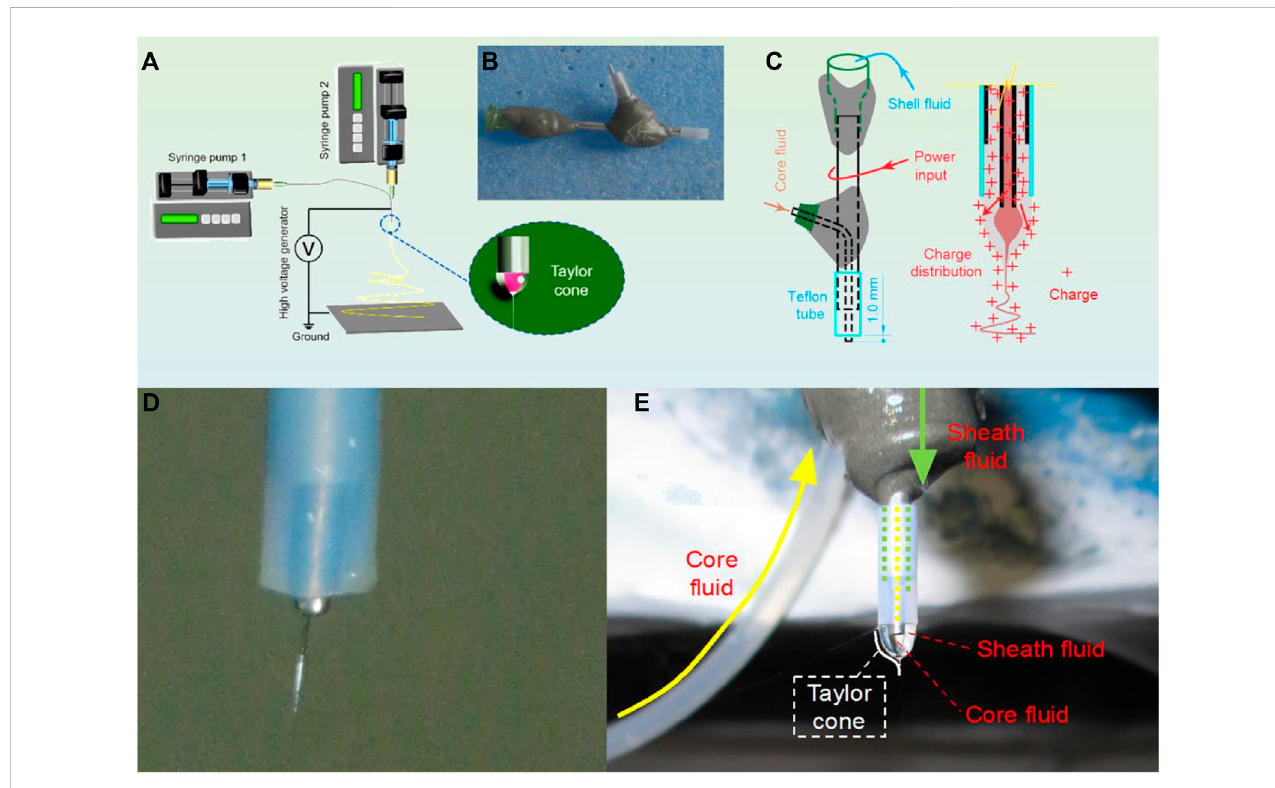
FIGURE 3 Implementationofthesingle- fl uidandcoaxialelectrospinningforcreatingSEDDS: (A) Adiagramshowingthecomponentsofanelectrospinningsystem; (B) The homemade concentric spinneret; (C) The electrohydrodynamic mechanism of ensuring an energy-saving process; (D) A typical Taylor cone of the single- fl uid blending electrospinning; and (E) a coaxial electrospinning